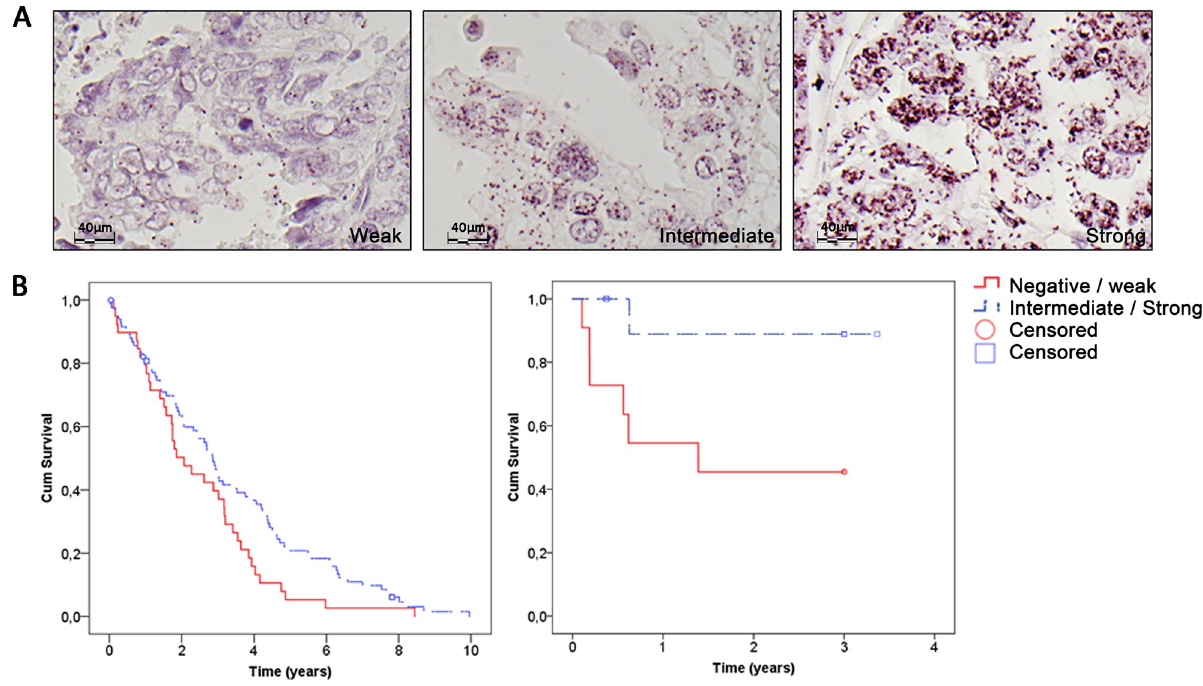
Fig 3. IGF1R/PCNA colocalization is associated with better survival in high-grade ovarian and oropharyngeal squamous cell carcinomas. A) Examples of scoring intensities of ovarian high-grade serous carcinomas (HGSC) in the tissue microarray (from left to right: weak, intermediate and strong). When comparing the survival of patients, the tumors’ staining intensity was clustered as negative/weak (score: +1) or intermediate/strong (score: +2/+3). B) Higher IGF1R/PCNA colocalization was associated with better overall survival in two clinical cohorts of 238 patients with HGSC (left, log rank. p = 0.037) and 23 patients with oropharyngeal squamous cell carcinomas (right, log. rank p = 0.027),